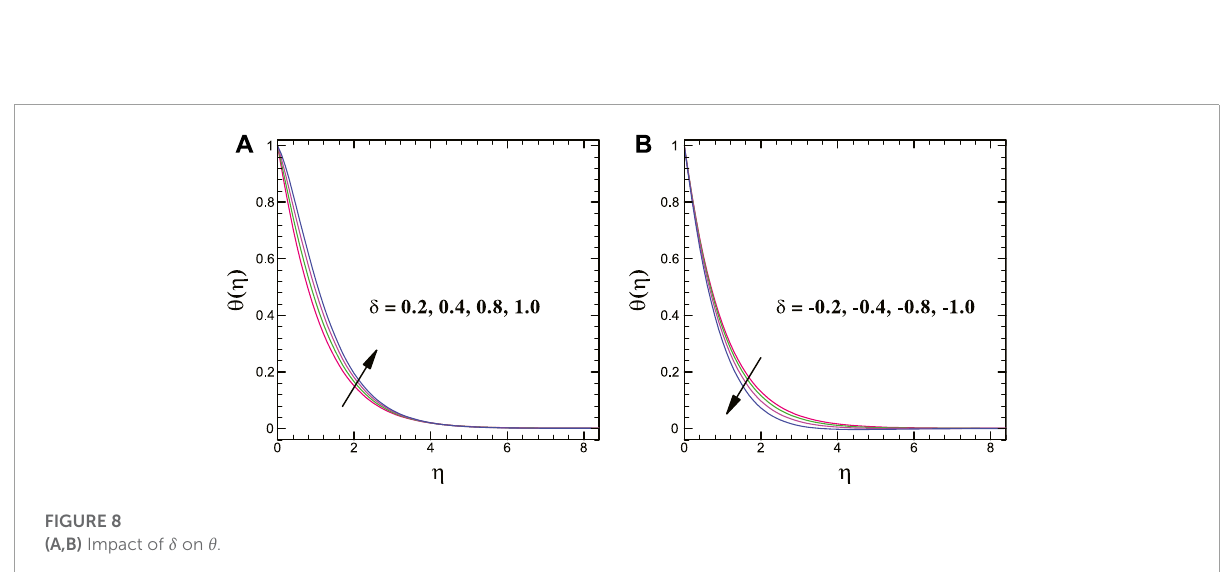
FIGURE 7 (A,B) Effect of β t and β c on θ and ϕ .